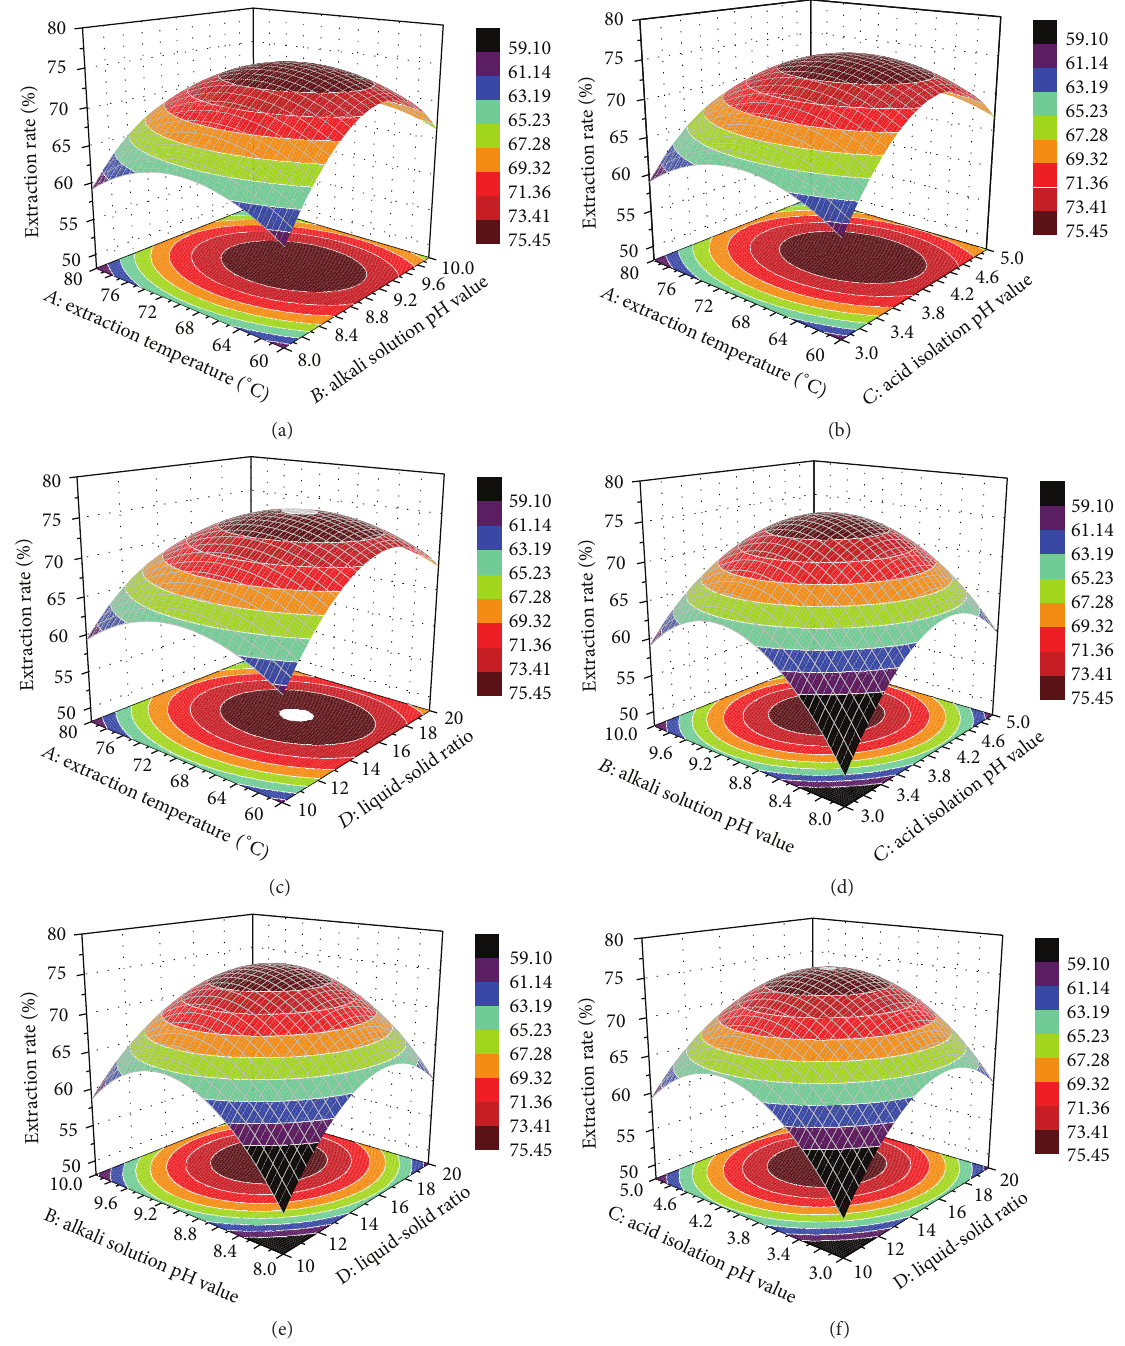
Figure7:Correspondingresponsesurfacesforextractionrateofsaponinfrom Camelliaoleifera cake.(a)Interactioneffectbetweenextraction temperatureandalkalisolutionpHvalueonextractionrateofsaponin;(b)interactioneffectbetweenextractiontemperatureandacidisolation pH value on extraction rate of saponin; (c) interaction effect between extraction temperature and liquid-solid ratio on extraction rate of saponin; (d) interaction effect between acid isolation pH value and alkali solution pH value on extraction rate of saponin; (e) interaction effect between alkali solution pH value and liquid-solid ratio on extraction rate of saponin; (f) interaction effect between acid isolation and liquid-solid ratio on extraction rate of